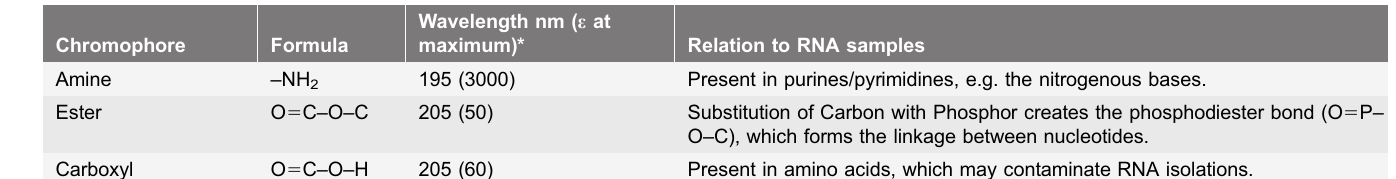
Table 2. UV absorption bands for chromophores, adapted from